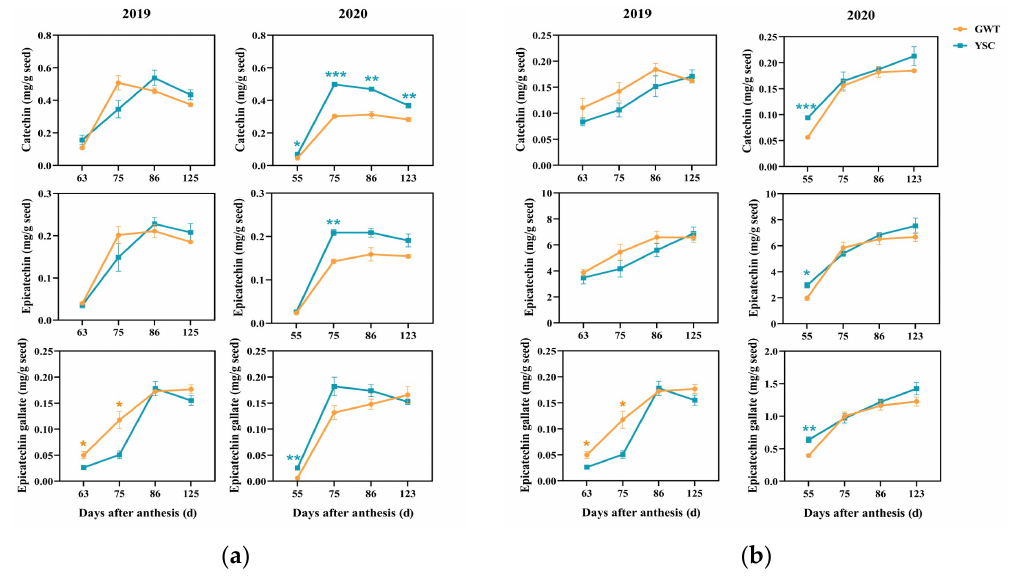
Figure 6. Changes in the content of terminal units ( a ) and extension units ( b ) in insoluble CT of GWT and YSC seeds. The asterisk indicates that there is a statistical difference between the two vineyards in the same period at the 0.05 level: *, p < 0.05; **, p < 0.01; ***, p <